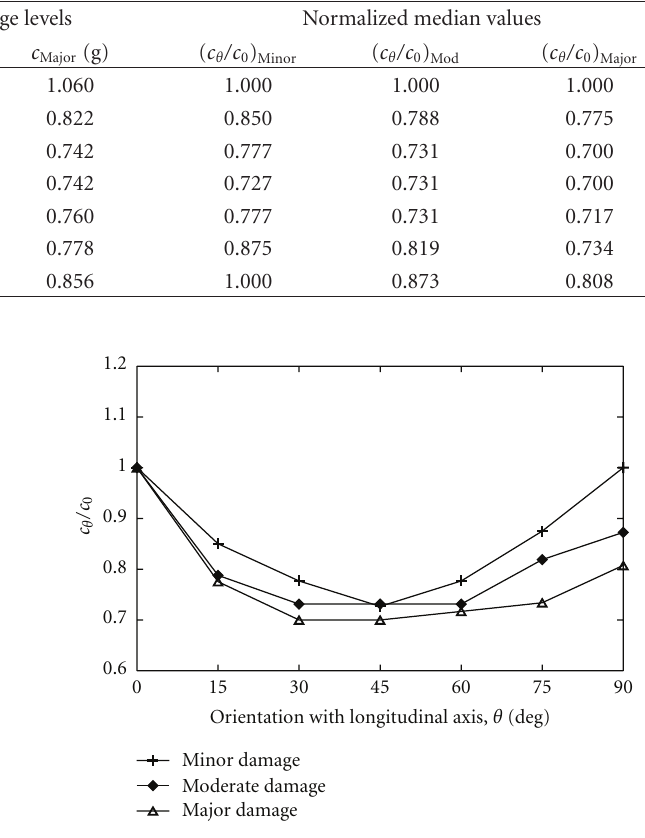
Figure 12: Variation of fragility parameter (median) with θ (case